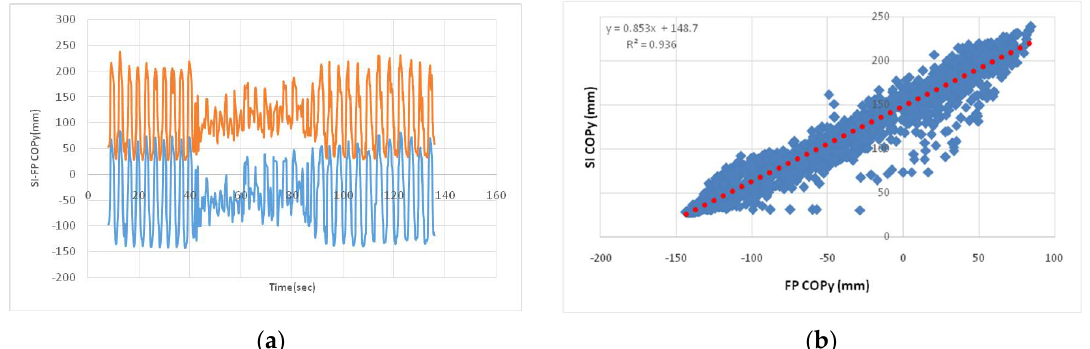
Figure 5. ( a ) COPy of SI (orange) and FP (blue) against time (one participant); ( b ) l inear regression fit function for COPy (mm) FP vs COPy (mm) SI (one participant).